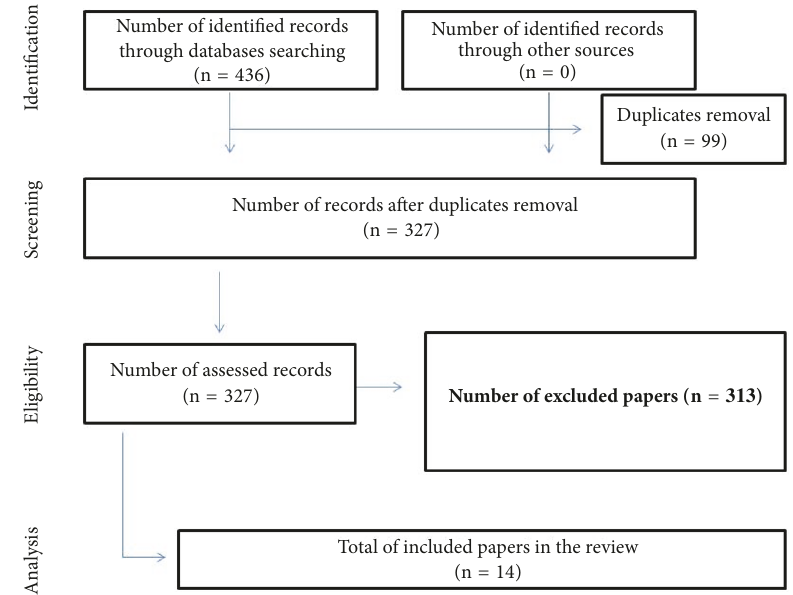
Figure 1: Flow diagram for identification, screening, eligibility, and analysis of studies included in the